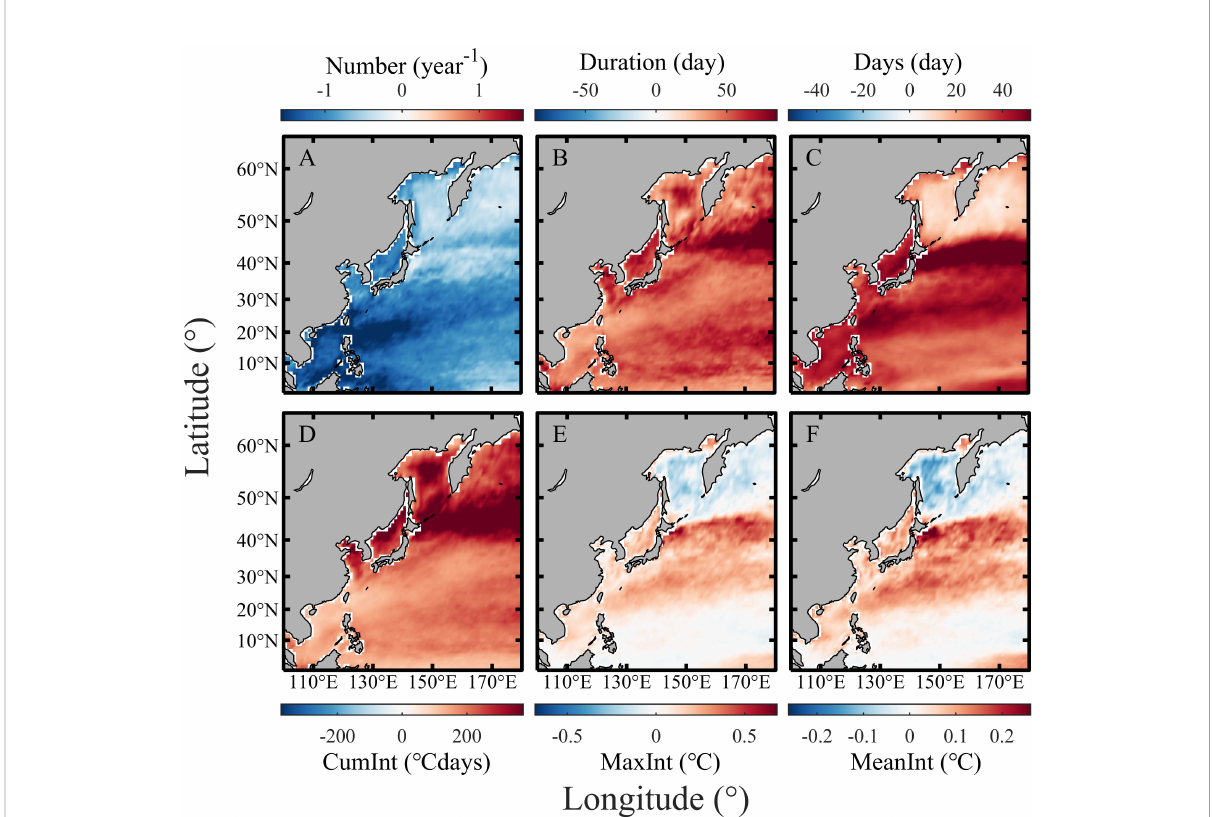
FIGURE 9 Spatial distribution of differences in projected MHWs characteristics under SSP2-4.5 and SSP5-8.5 scenarios (SSP5-8.5 minus SSP2-4.5). Multi- year average of (A) MHWs Number (units: year -1 ), (B) Duration (units: day), (C) Days (units: day), (D) CumInt (units: °Cdays), (E) MaxInt (units: °C), and (F) MeanInt (units: